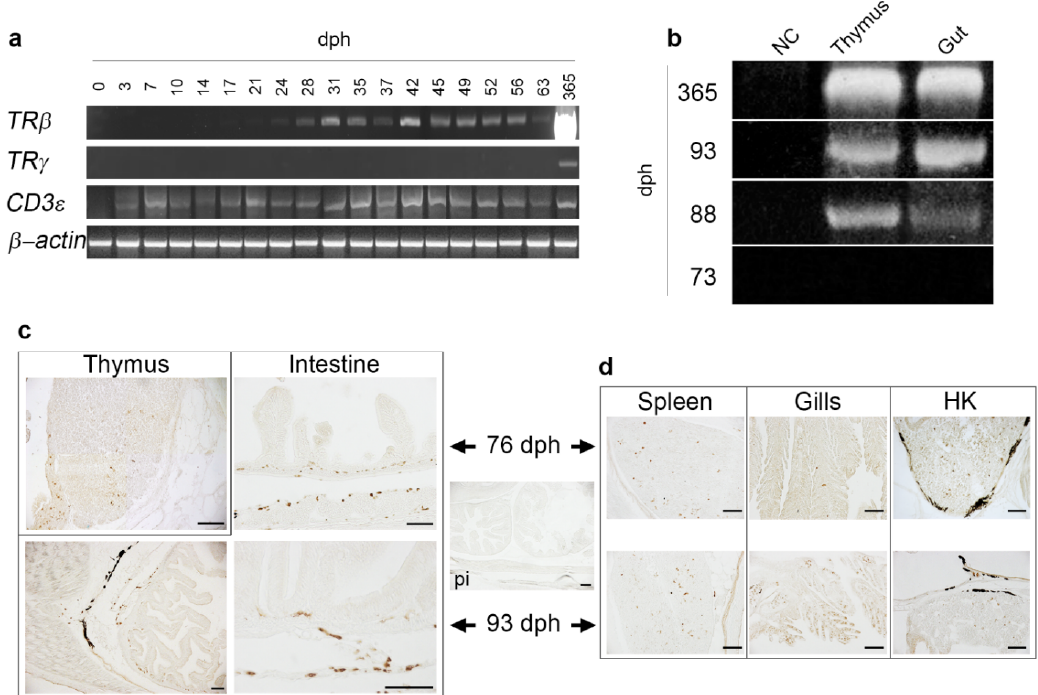
Figure 2. ( a ) RT-PCR of different T cell markers along the first 63 days of D. labrax ontogeny and in a thymus of a 365-day-old specimen. β -actin served as housekeeping gene. ( b ) RT-PCR of TR γ performed on two immune-relevant tissues at 73–93 dph ontogeny and 365-day-old stages. ( c , d ) Immunohistochemistry photographs of thymus, intestine, spleen, gills and HK of 76- and 93-dph larvae stained with RaTR γ 1 IgG diluted 1:100 in PBS. Scale bars are all 50 μ m.